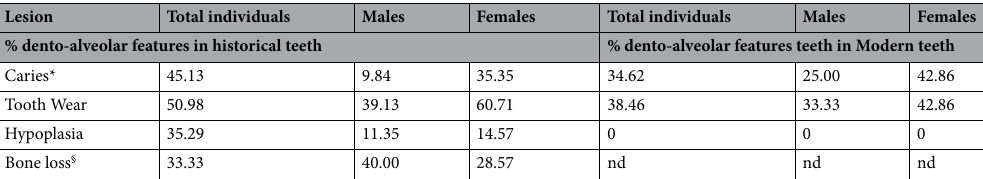
Table 1. Macroscopic investigation of dental calculus of the examined skeletal fragments, teeth and mandibulae (% per gender) coming from historical and modern individuals. The macroscopic investigation of dental calculus was performed per tooth and describes the frequencies of dento-alveolar features by sex. Total historical teeth n = 51; Historical males teeth n = 23; Historical females teeth n = 28. Total modern teeth n = 26 Modern males teeth n = 12; Modern females teeth n = 14. *% carious lesions in teeth (number of decayed teeth/ total teeth). § Data related to alveolar